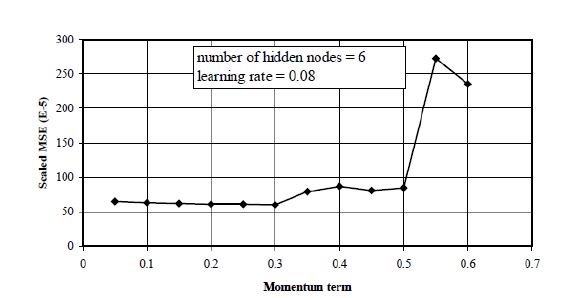
Figure 4. Influence of momentum term on ANN model performance in validation set. MSE: mean squared error.